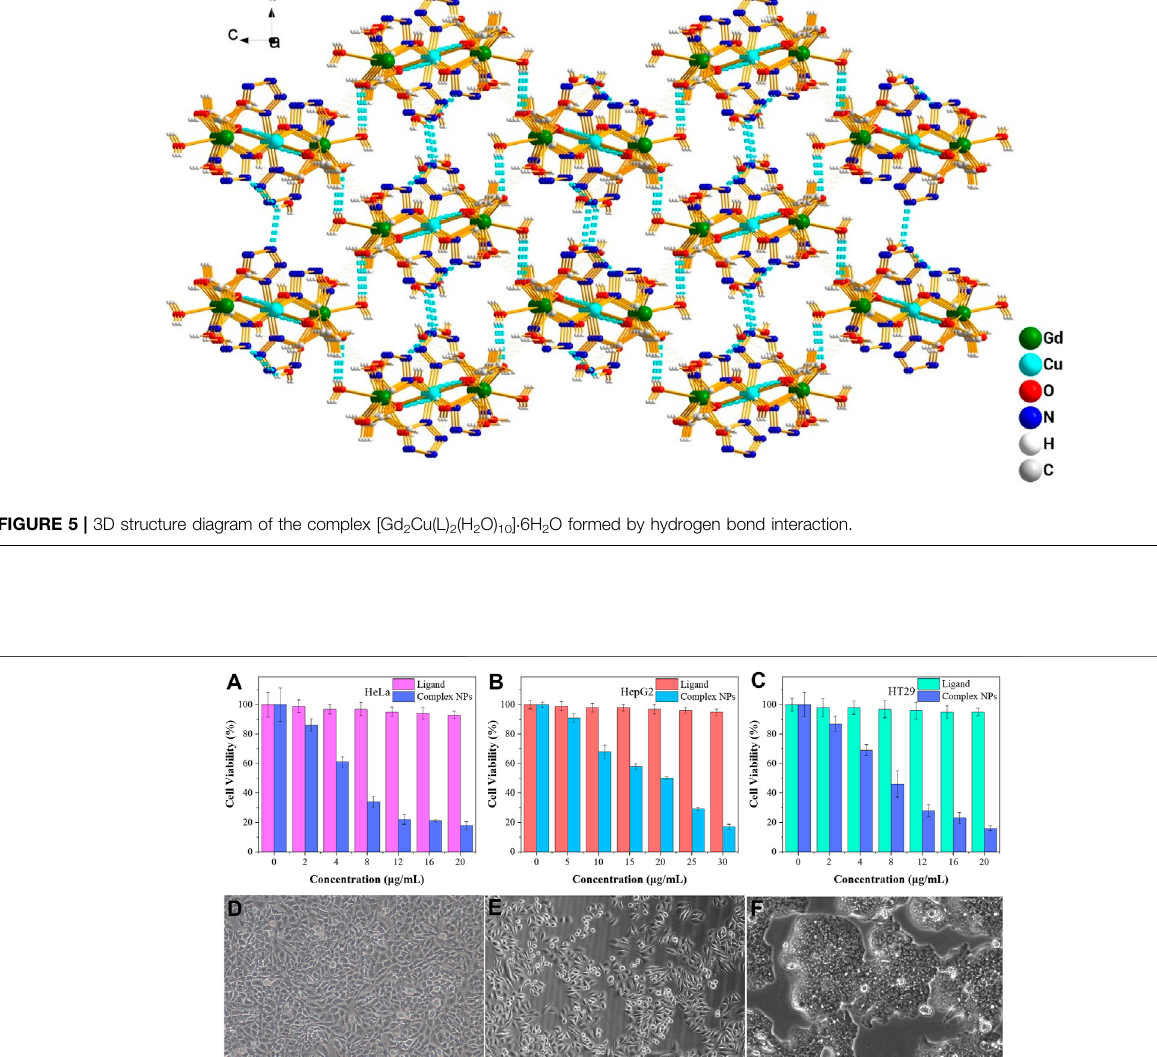
Frontiers in Chemistry |